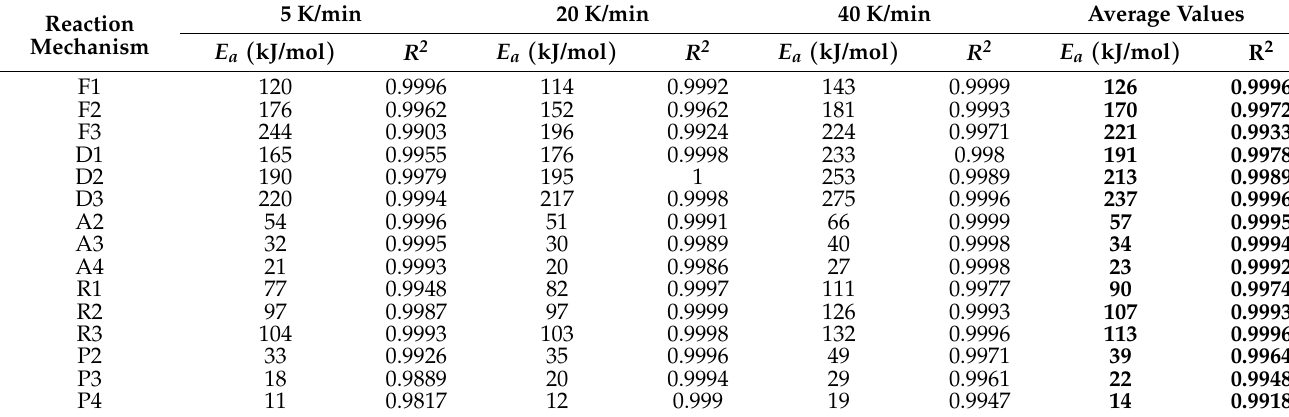
Table 8. Kinetic parameters of the pyrolysis of plastic mixtures by Coats–Redfern model (tests 4–6). Reaction Mechanism